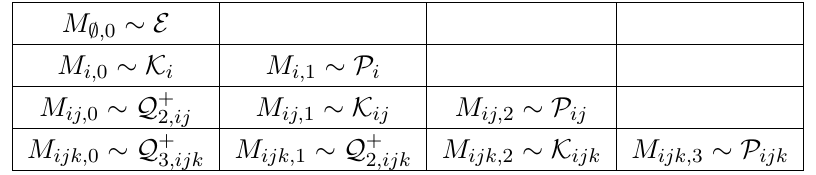
Table 1 . First sets ( ‘ ≤ 3 ) of parity-even conserved charges of non-radiative asymptotically flat spacetimes. The symbol ∼ means “is proportional to”.